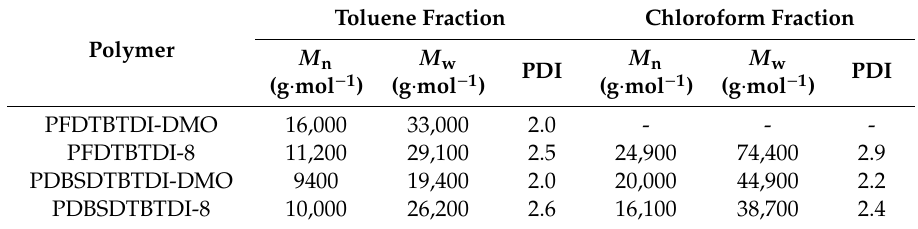
Table 1. The percentage yield, weight and number average molecular weights with polydispersity